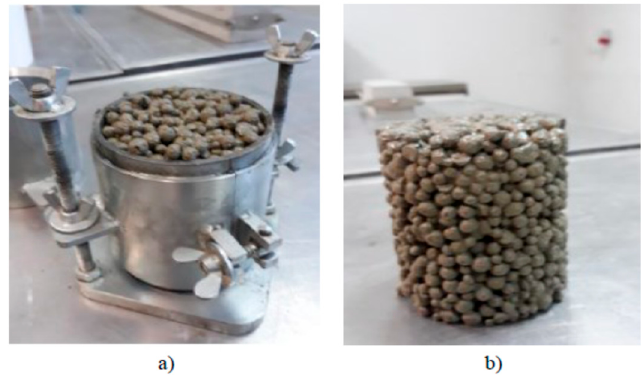
Figure 7. Preparation of a sample mixture with GEGA ( a ). Sample of the mixture with GEGA for compression strength tests ( b ).